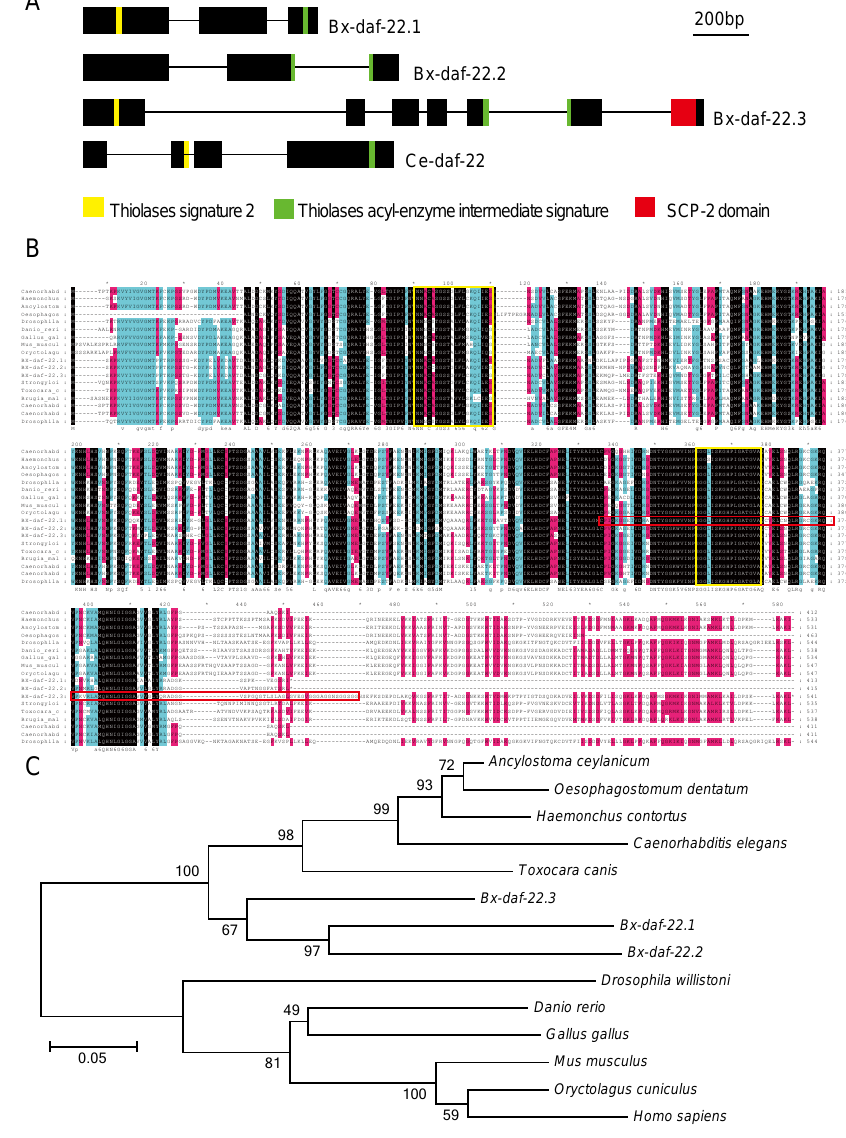
Figure 2. Characterization of Bx-daf-22 genes in B. xylophilus . ( A ) The gene structure and protein domains of Bx-daf-22.1 , Bx-daf-22.2, and Bx-daf-22.3 in B. xylophilus compared with orthologs gene Ce-daf-22 in C. elegans . Lines represent introns and black boxes represent exons. ( B ) Alignment of B. xylophlus Bx-daf-22 with other species. Protein sequences were aligned using DNAMAN 8. Shaded parts indicate residues that are consistent. The first yellow box represents the thiolases acyl-enzyme intermediate signature and the second yellow box represents the thiolases signature 2. The red box represents the SCP2 domain. ( C ) Phylogenetic tree of Bx-daf-22 and its homologues from other parasitic or free-living nematodes, insects and vertebrates. One thousand bootstrap replicates were performed, and the node labels represent the present bootstrap support. The accession number of these sequences are: ( Caenorhabditis elegans , Maupas) NP_496639.1, ( Haemonchus contortus , Rudolphi) AEO14647, ( Ancylostoma ceylanicum , Looss) EYC23922.1, ( Oesophagostomum dentatum , Goodey) KHJ80319.1, ( Drosophila willistoni , Sturtevant) XP_002065586.1, ( Danio rerio , Hamilton) NP_957159.1, ( Gallus gallus , Linnaeus) NP_001292129.1, ( Mus musculus , Linnaeus) NP_035457.1, ( Oryctolagus cuniculus , Linnaeus) NP_001075504.1, ( Strongyloides ratti , Grassi and Segre) CEF60652.1, ( Toxocara canis , Werner) KHN79232.1, ( Brugia malayi , Brug) XP_001902124.1, ( Caenorhabditis briggsae , Dougherty and Nigon) XP_002631757, ( Caenorhabditis remanei , Sudhaus) XP_003109848, and ( Drosophila mojavensis , Patterson)